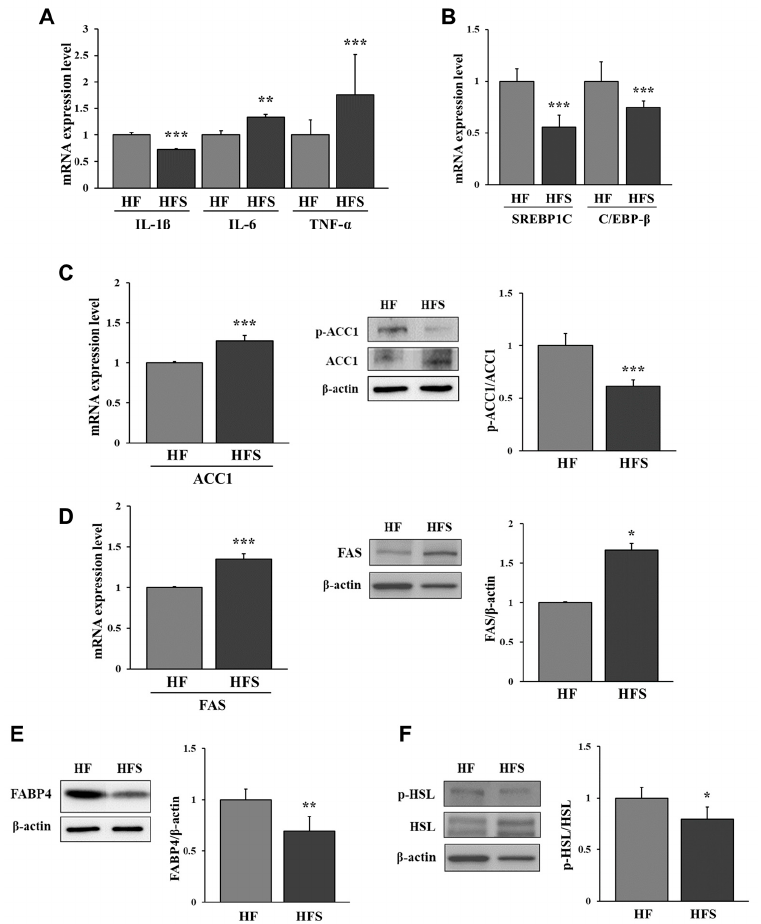
Figure 3. Relative mRNA expression of pro-inflammatory cytokines, IL-1 β , IL-6, and TNF- α ( A ), SREBP1C, and C/EBP- β ( B ), relative mRNA and protein expression of ACC1 ( C ) and FAS ( D ), and protein expression of FABP4 ( E ) and HSL ( F ) in the epididymal white adipose tissue of mice. C57BL/6J mice were fed a high-fat diet (HF; AIN-93G with 60 kcal% fat) or a high-fat diet with 10% sucrose water (HFS) for 12 weeks. All data are expressed as the mean ± standard deviation. Statisti- cal analyses were performed using Student’s t -test ( n = 3, HF vs. HFS; *, p < 0.05, **, p < 0.01, ***, p < 0.001). IL-1 β , interleukin-1 beta; IL-6, interleukin-6; TNF- α , tumor necrosis factor-alpha; SREBP1C, sterol regulatory element-binding protein-1C; C/EBP- β , CCAAT/enhancer-binding protein-beta; ACC1, acetyl-CoA carboxylase 1; FAS, fatty acid synthase; FABP4, fatty acid-binding protein 4, HSL, hormone-sensitive lipase.